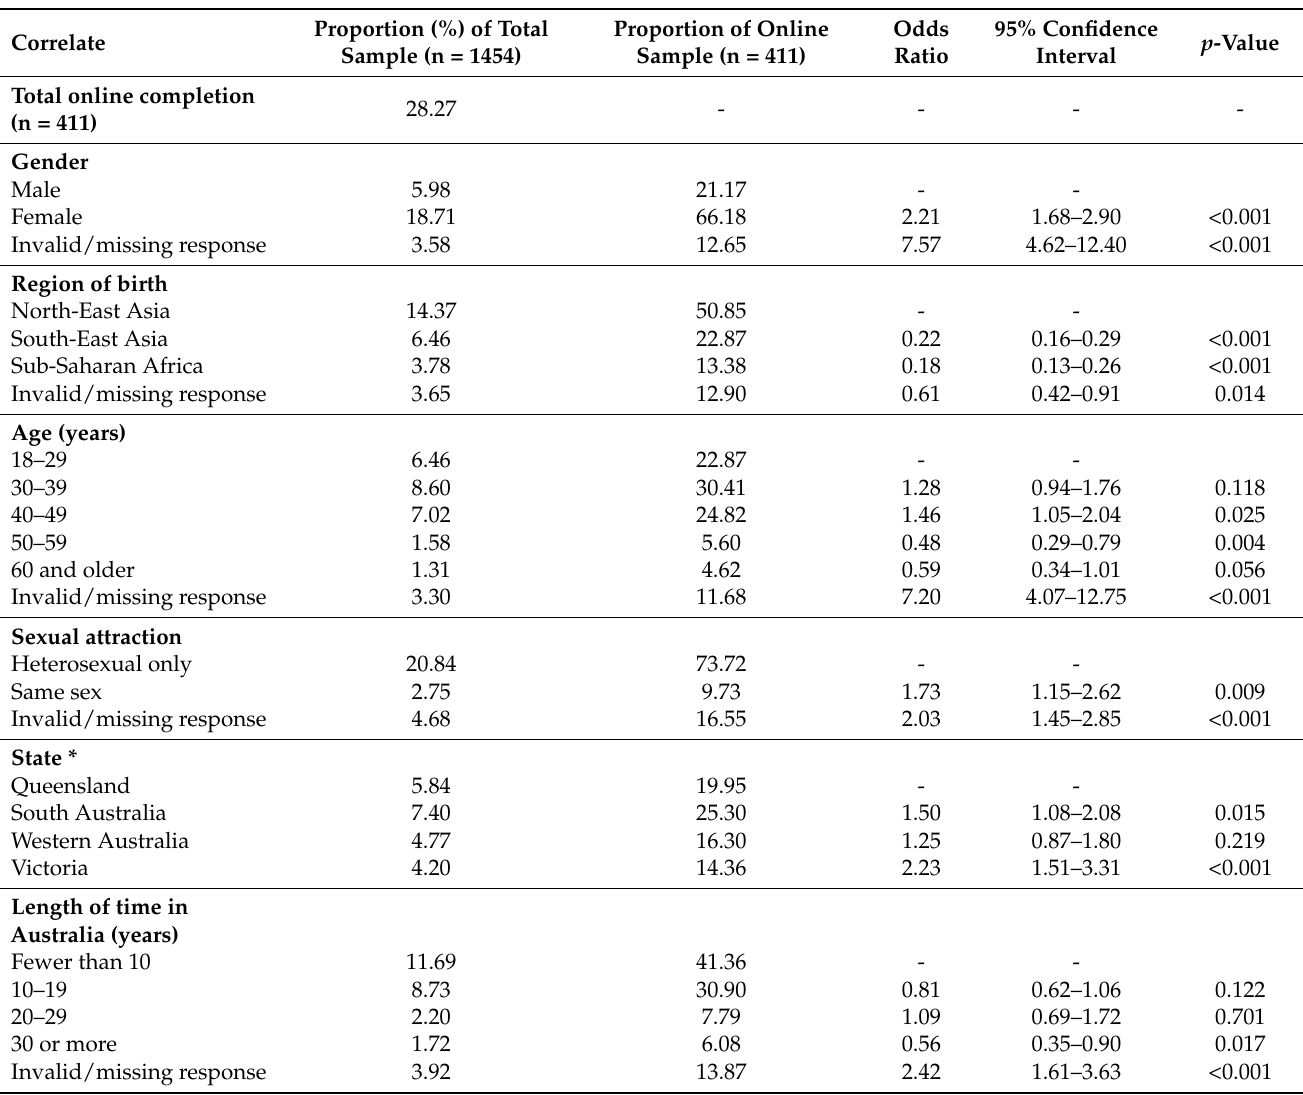
Table 4. Characteristics of participants completing the online